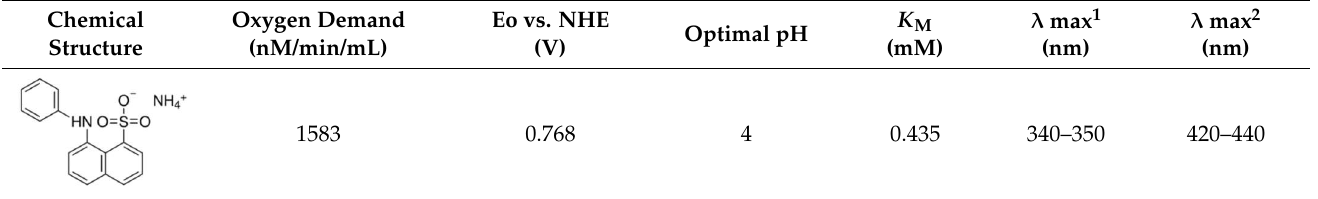
Table 1. Characteristics of the main catalytic parameters of 8-anilino-1-naphthalenesulfonic acid (ANS) as the potential substrate in terms of LAC-mediated oxidation.